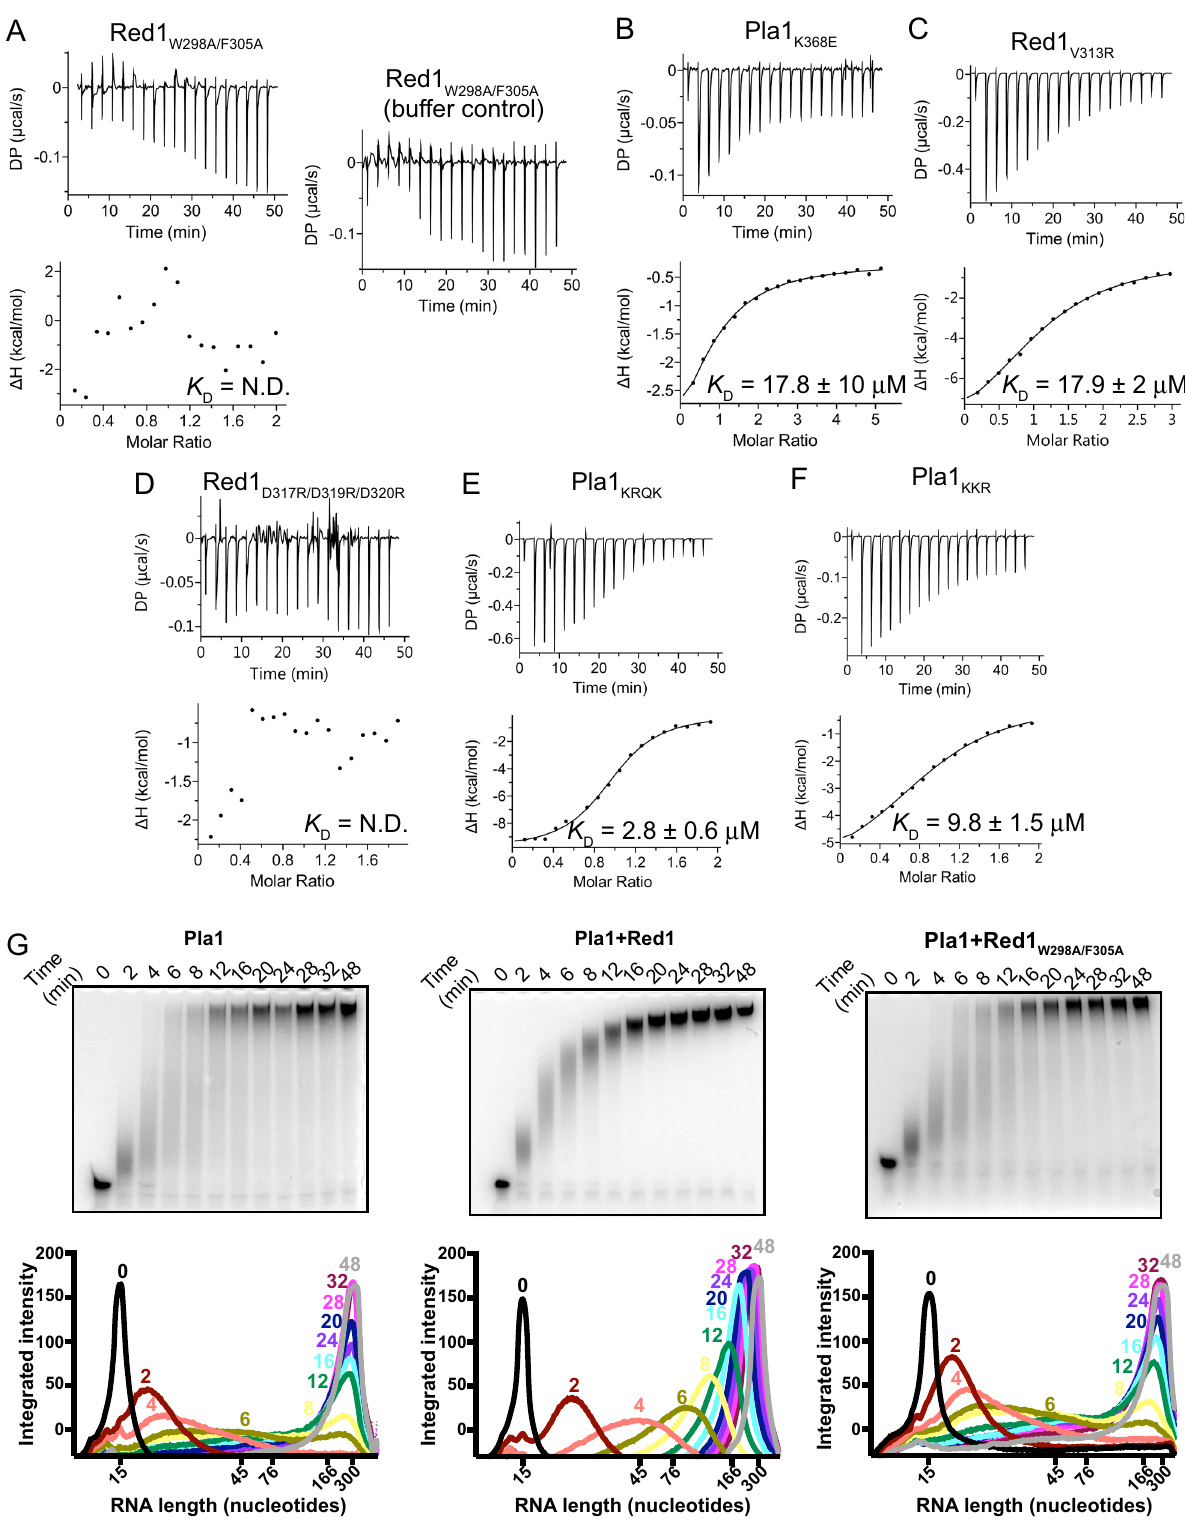
Fig. 3 | Mutational analyses of Pla1-Red1 interaction. Isothermal titration calorimetryexperimentswith speci fi cPla1and Red1 point mutantsthataffecttheir interactioninterfaceareshowninpanels A – F .Thecalculateddissociationconstant ( K D ) from an average of two independent measurements is shown. G In vitro polyadenylation assay. Polyadenylation of a 5 ′ -Cy3 labelled A 15 RNA primer by Pla1